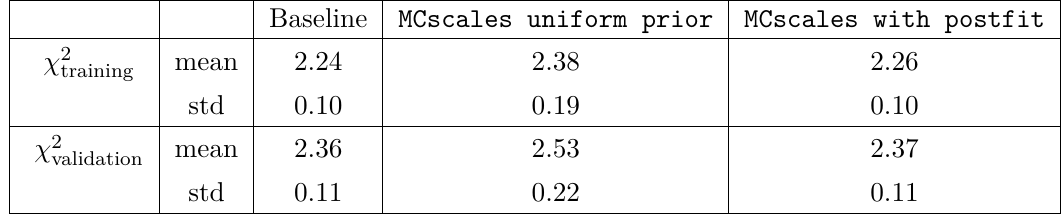
Table 1 . The mean values and standard deviations of the χ 2 to the training and validation data sets, computed from the distributions shown in figure 1. Note that all χ 2 values are per data